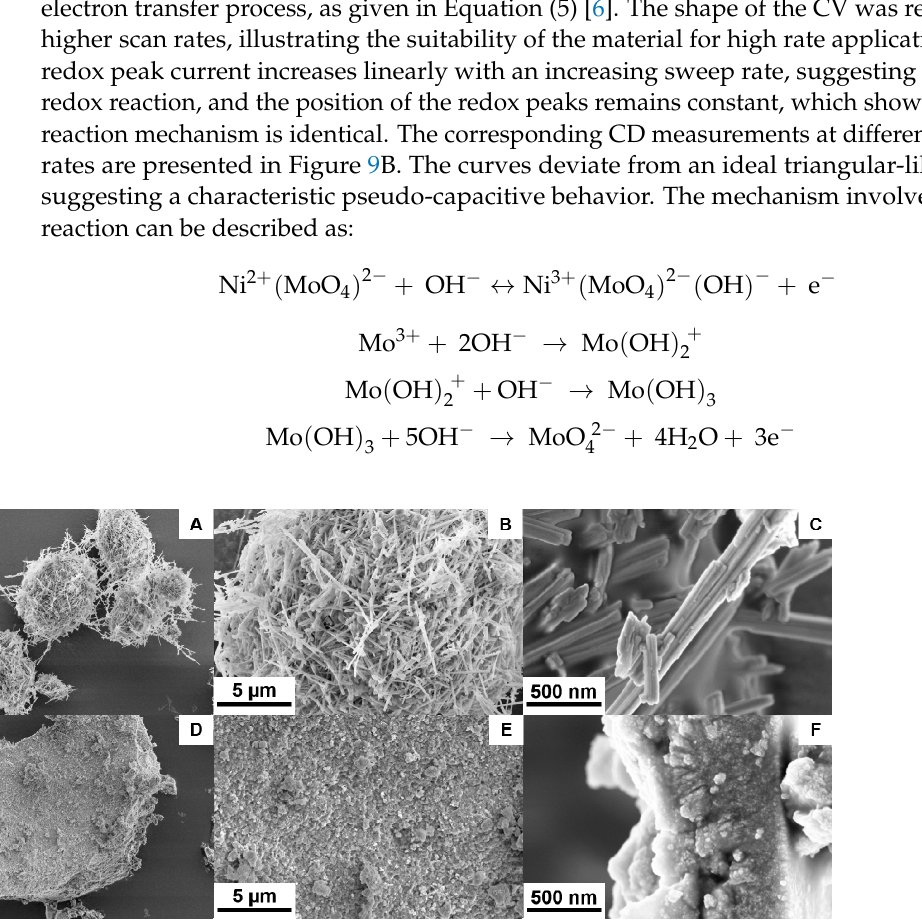
Figure 6. SEM images using a secondary electron (SE) detector at different magnifications: ( A – C ) NiMoO 4 , ( D – F ) NiWO 4 samples obtained by hydrothermal synthesis.